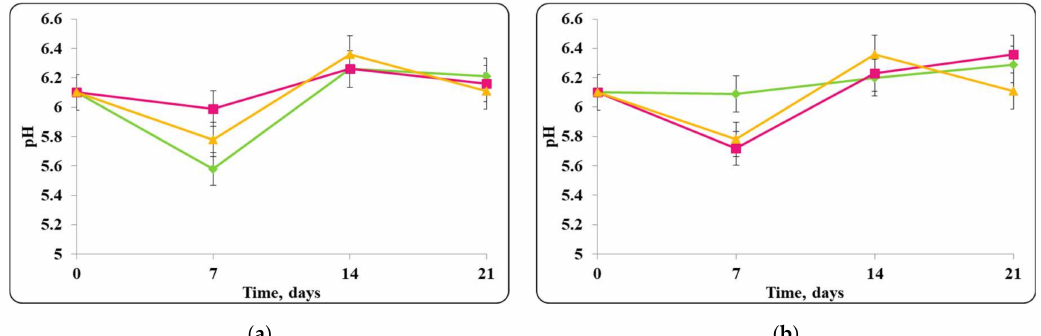
Free Lb. helveticus 2/20 cells in co-culture with E. coli